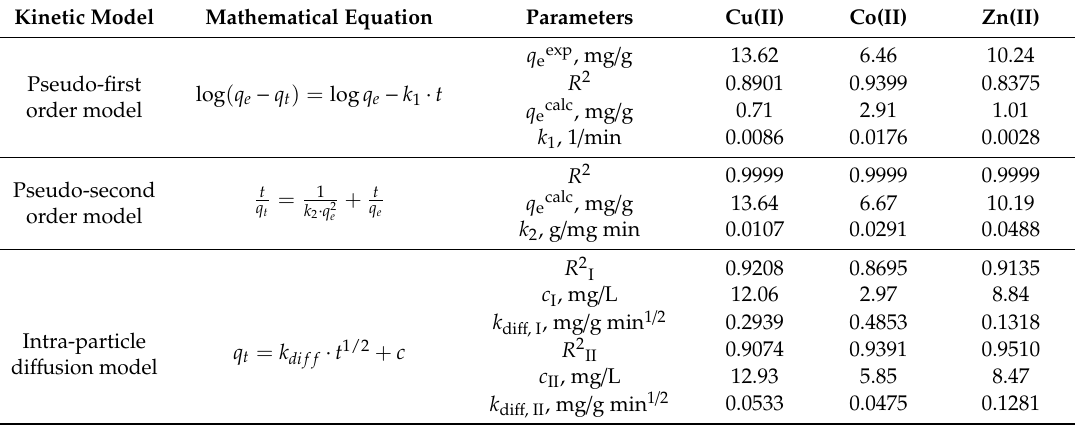
Table 1. Kinetic parameters calculated for the biosorption of Cu(II), Co(II) and Zn(II) ions on